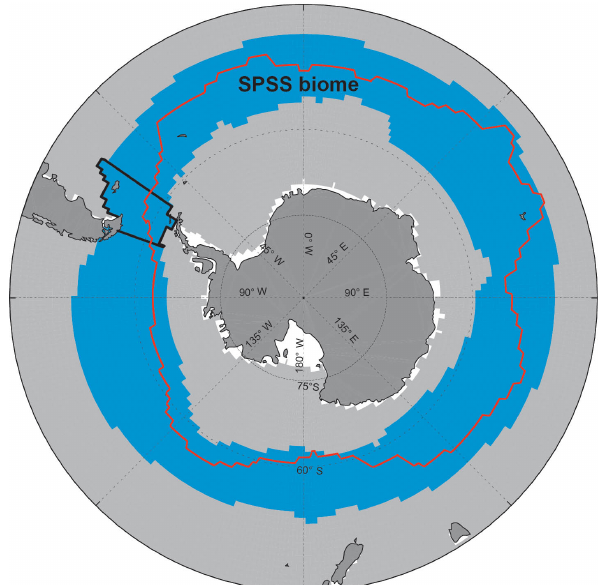
Figure 1. Map of the Subpolar Seasonally Stratified (SPSS) biome (Fay and McKinley, 2014), defined at 1 ◦ × 1 ◦ resolution. The red line represents the mean location of the Antarctic Polar Front (Free- man and Lovenduski, 2016), interpolated to a 1 ◦ × 1 ◦ grid. The black box represents the Drake Passage region considered in this